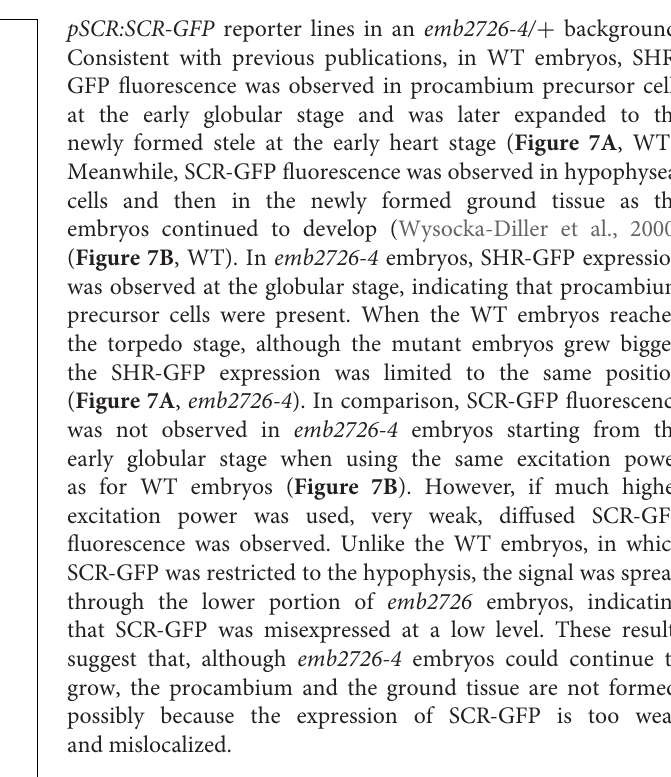
as reported previously (Lau et al., 2012). Together with the findings for DR5:GFP and DRN-GFP, the results indicate that the auxin redistribution, instead of a change in auxin